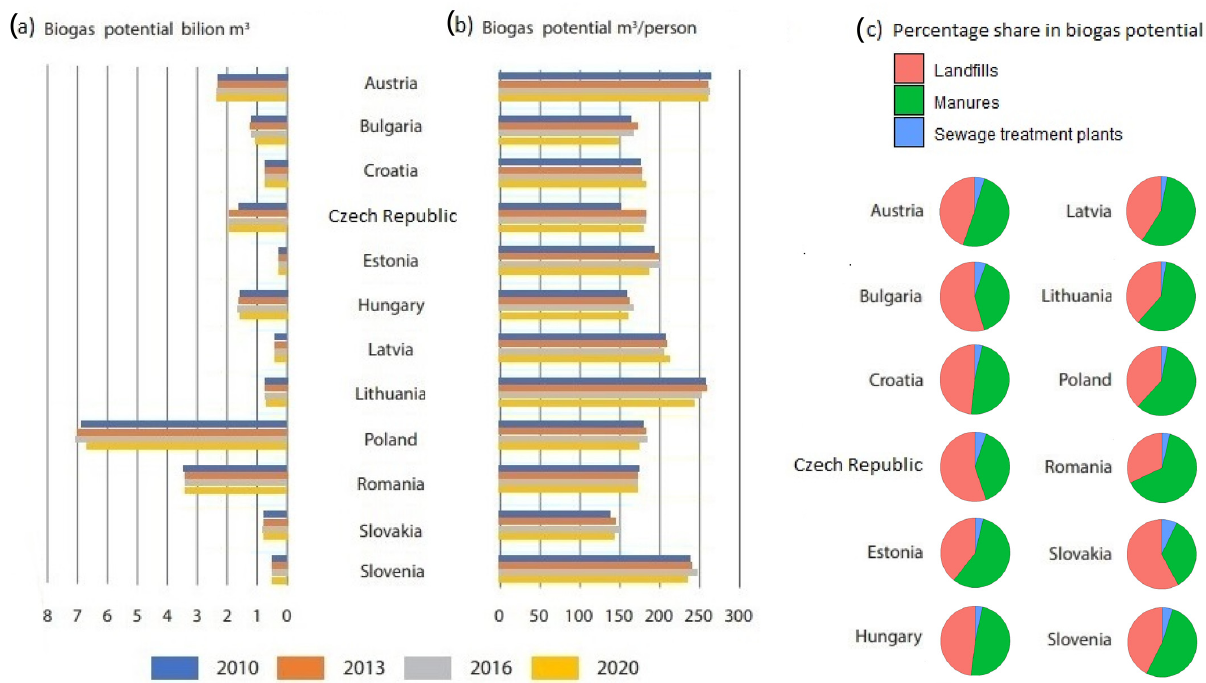
Figure 2. Biogas potential ( a ) per population ( b ) and with percentage share of individual sources at national level ( c ).